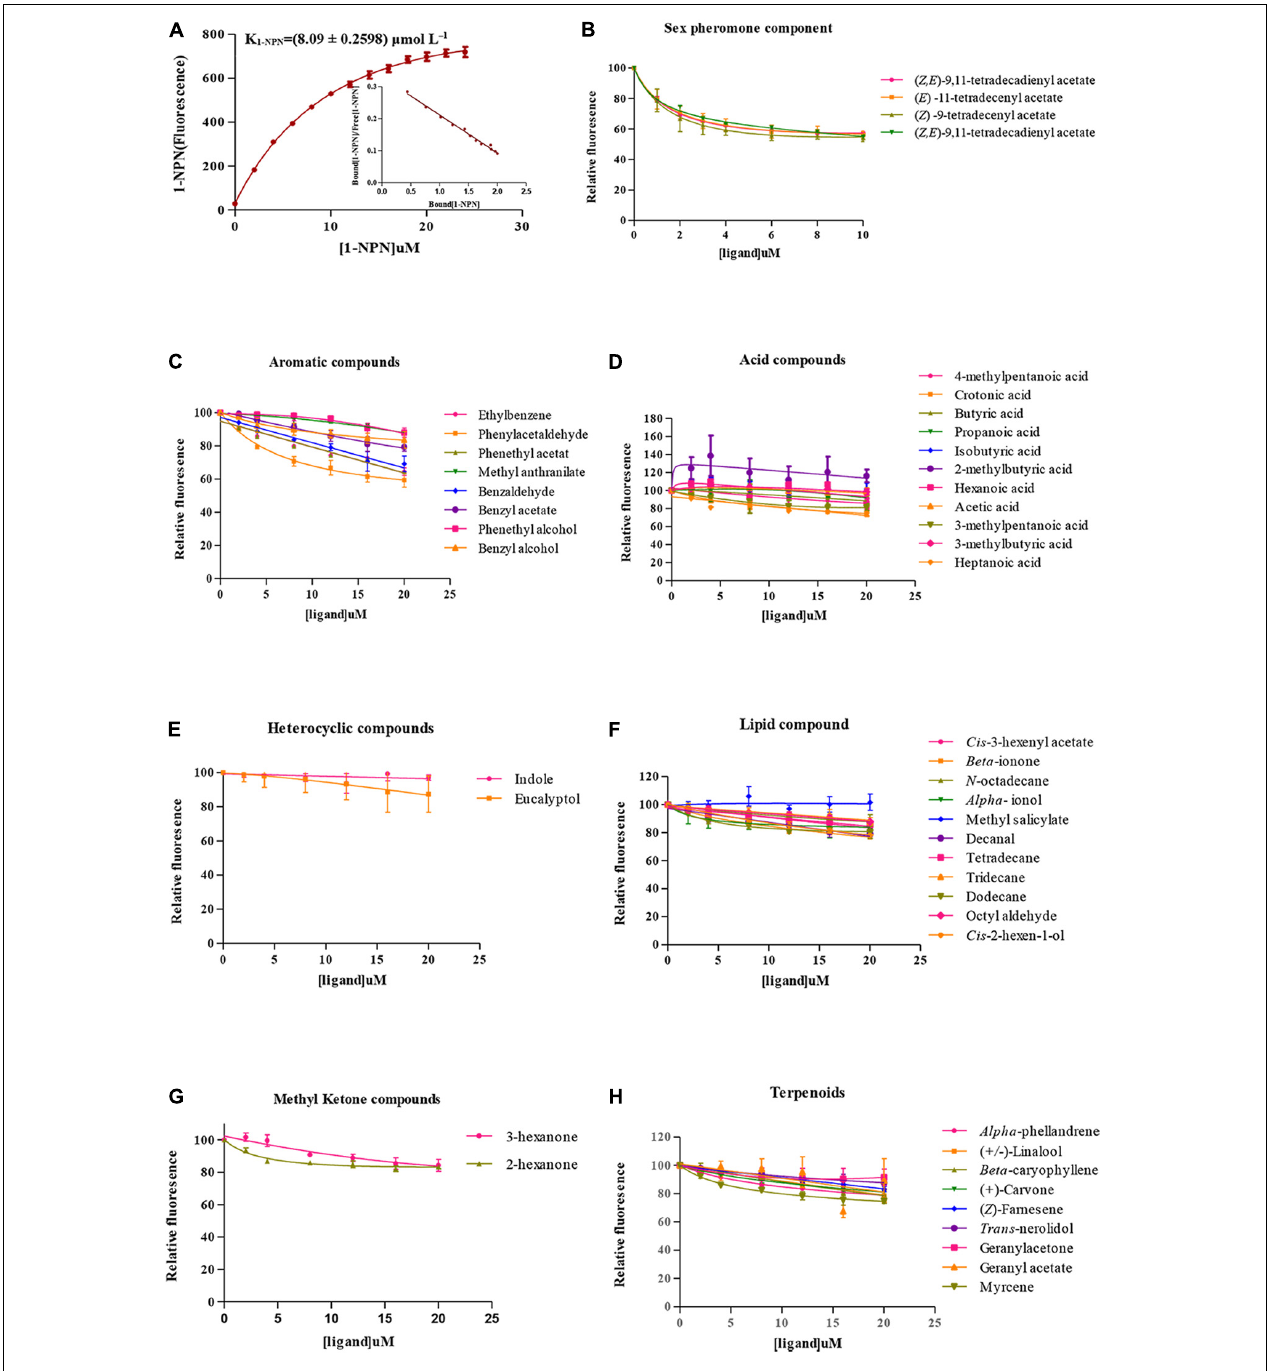
FIGURE 4 | Fluorescence competitive binding assay. (A) Binding curve of 1-NPN to SlitOBP11 and Scatchard plot. (B) Binding curve of SlitOBP11 with sex pheromones of female. (C–H) Binding curve of SlitOBP11 with plant volatile